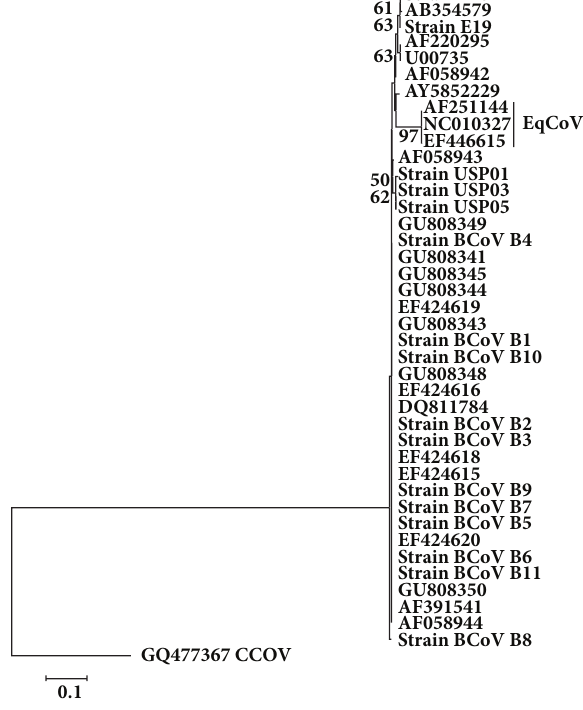
Figure 4: Phylogenetic tree for partial sequences of N gene (nt. 156 to 359 of Mebus strain GenBank accession number U00735.2). Strains of the present study are in bold. The numbers at each node are the bootstrap values obtained with 1,000 replicates (only values > 50 are shown). The bar represents the number of substitutions per site.